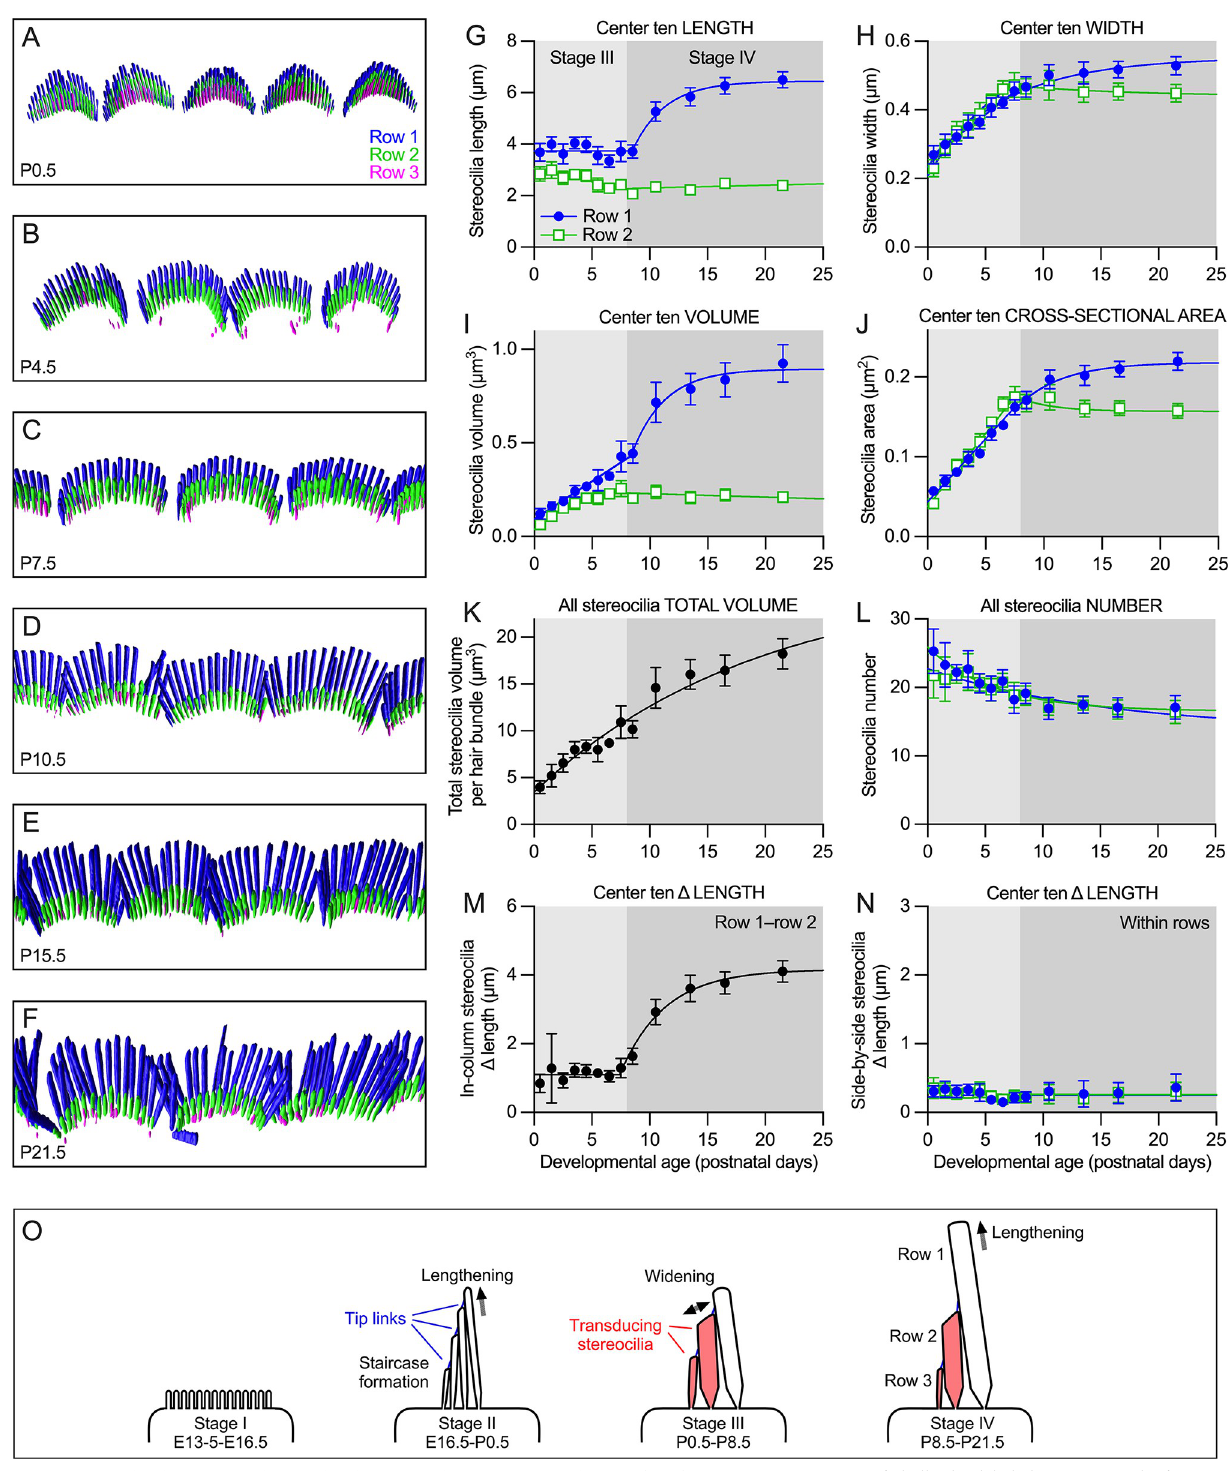
Fig 1. AU : AbbreviationlistshavebeencompiledforthoseusedinFigs 1 to 15 : Pleaseverifythatallentriesarecorrect : Stereocilia dimensions during development of C57BL/6J apical IHCs. ( A–F ) Imaris reconstruction of phalloidin-labeled IHC stereocilia from indicated ages. Stereocilia surfaces are color-coded according to row; each box is 14 × 35 μ m. Imaris reconstructions show overlapping hair bundles of adjacent cells, presumably an artefact of sample preparation. ( G–N ) IHC stereocilia dimension measurements using reconstructed stereocilia surfaces. ( G ) Rows 1 and 2 stereocilia length during development; center 10 stereocilia in each row. Row 1 data were fit with a line with slope of zero from P0.5– P7.5 followed by an exponential climb from P7.5–P21.5; row 2 data were fit with an exponential decline. ( H ) Rows 1 and 2 stereocilia width (center 10). In